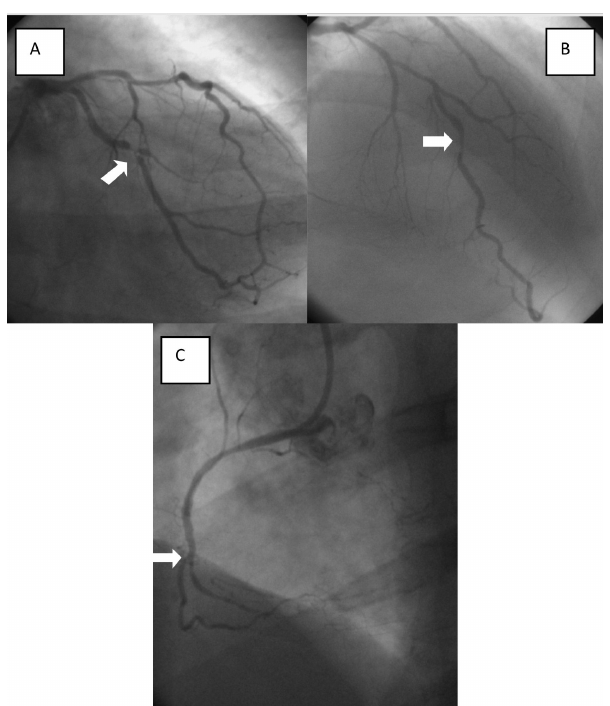
Figure 1 - A. Circumflex coronary artery with 95% obstruction. B. Anterior descending coronary artery with 70% obstruction. C. Right coronary artery with a 100% distal